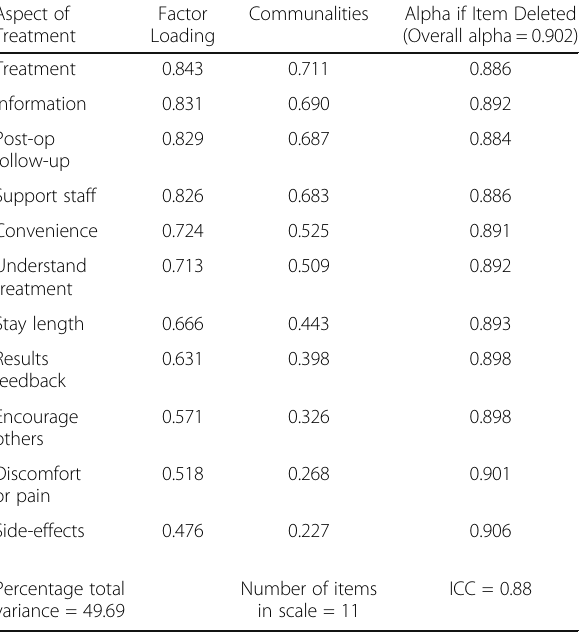
Table 8 AneurysmTSQ factor loadings, communalities and reliability coefficients: Post-repair patients